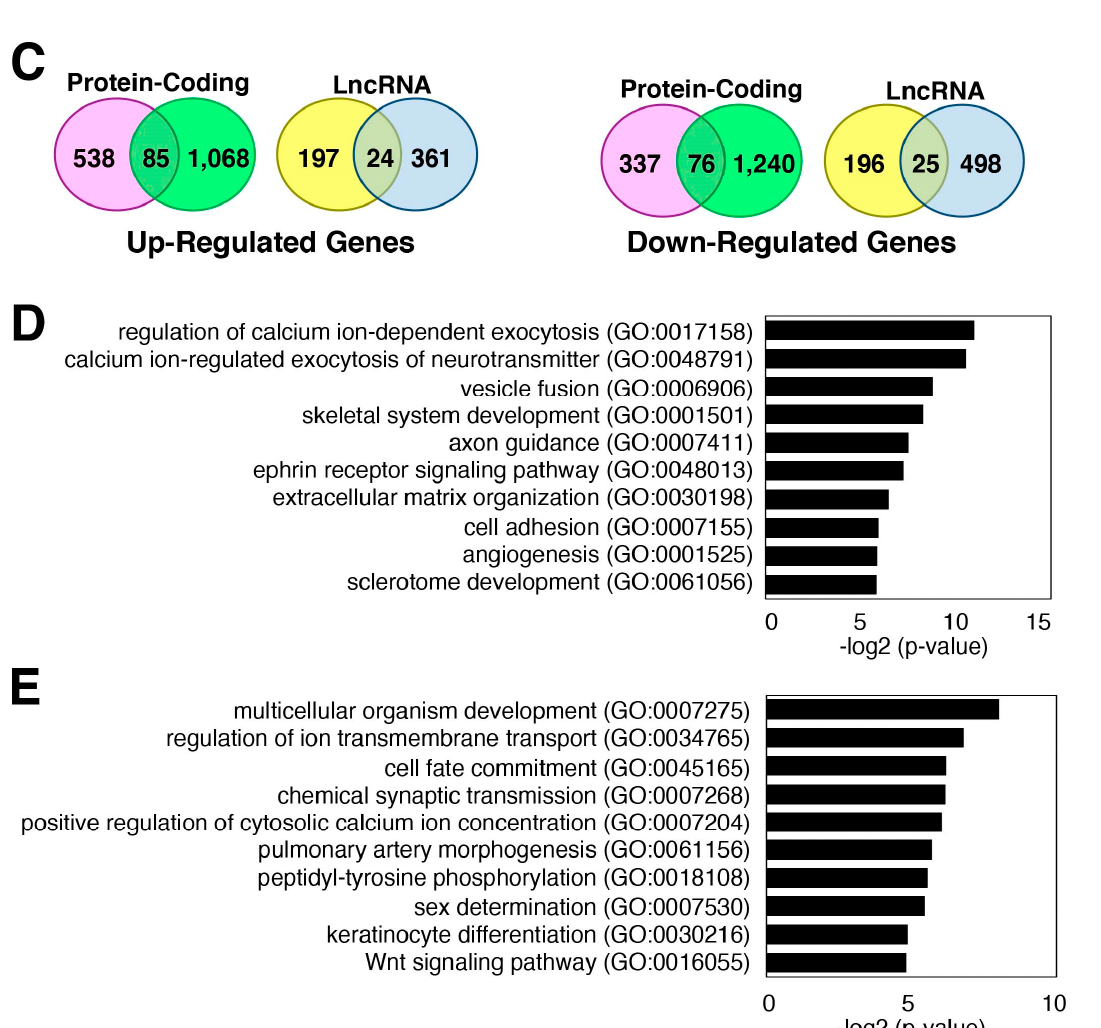
Figure 3. Gene expression changes in activated fibroblasts, myofibroblasts. ( A , B ) Differential gene expression in MRC5 fibroblastic cell line treated with TGF- β . ( A ) Volcano plot of all genes, including protein-coding and lncRNA genes. The up-regulated protein-coding genes are shown in blue, lncRNA genes in dark green, and other RNA species (based on biotypes provided by the Ensembl database) in olive. The down-regulated protein-coding genes are shown in red, lncRNA genes in pink, and other RNA in purple. With the threshold values of 2-fold and FDR-adjusted p < 0.05, there are 1692 up- and 1957 down-regulated genes in TGF- β -treated MRC5 cells compared to non-treated cells (control) ( n = 3 technical replicates). ( B ) Violin plots of RNA-seq data plotted separately for each replicate as indicated above. ( C ) Venn diagrams of differentially expressed genes in two datasets: Fibroblasts from CTEPH patients (in pink or yellow) and MRC5 cells treated with TGF- β (in green or light blue). ( D , E ) Top 10 enriched GO terms (biological process) for shared ( D ) up- and ( E ) down-regulated protein-coding genes in two datasets.